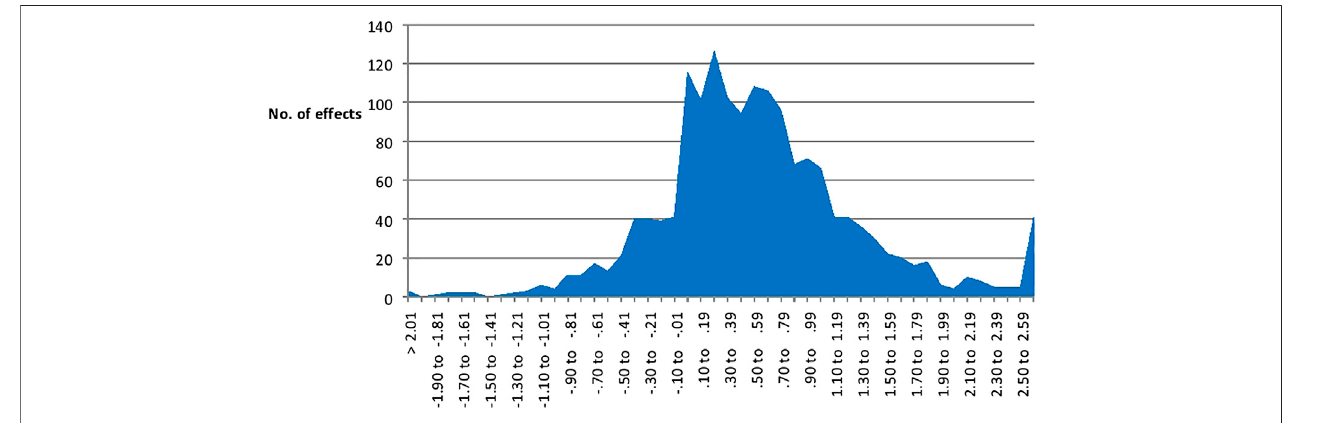
FIGURE 2 | Distribution of